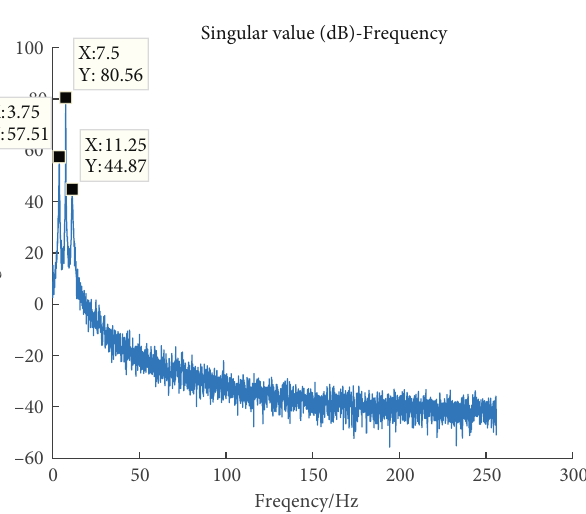
Figure 10: PSD of the three-mode turbulence response.